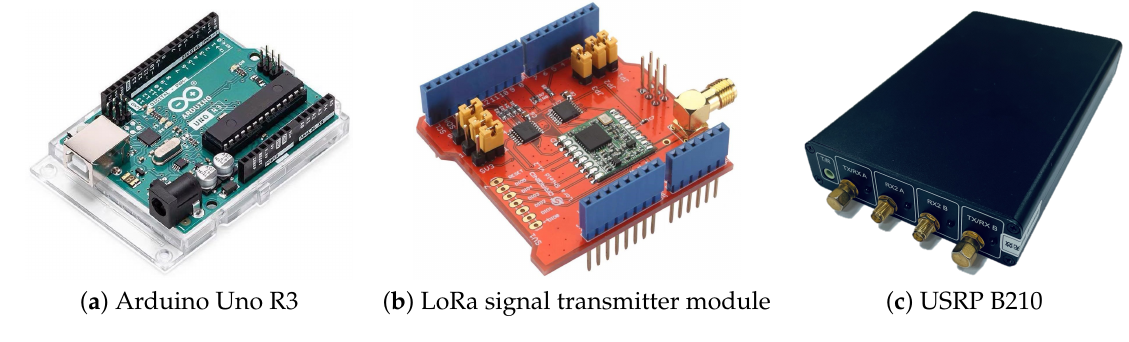
Figure 9. Experiment apparatus.